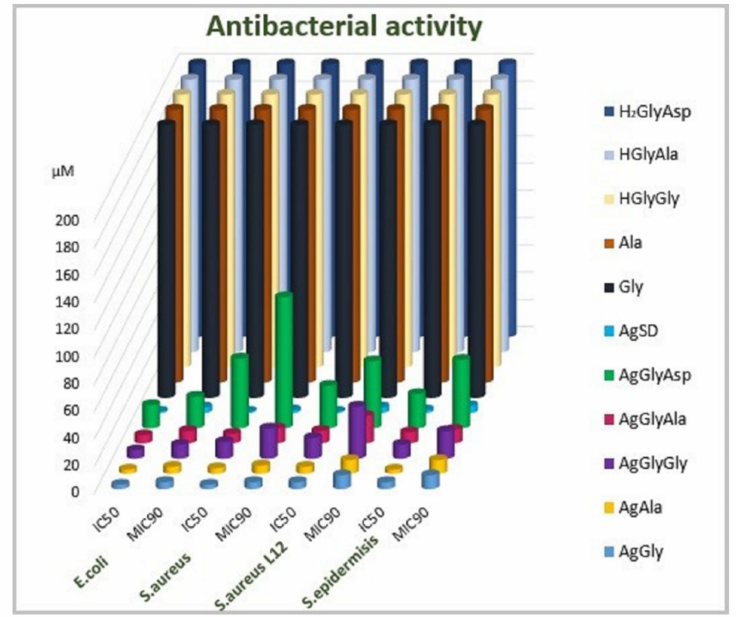
Figure 3. Antibacterial activity of silver(I) complex and free ligands (IC 50 , MIC 90 : µ mol · L − 1